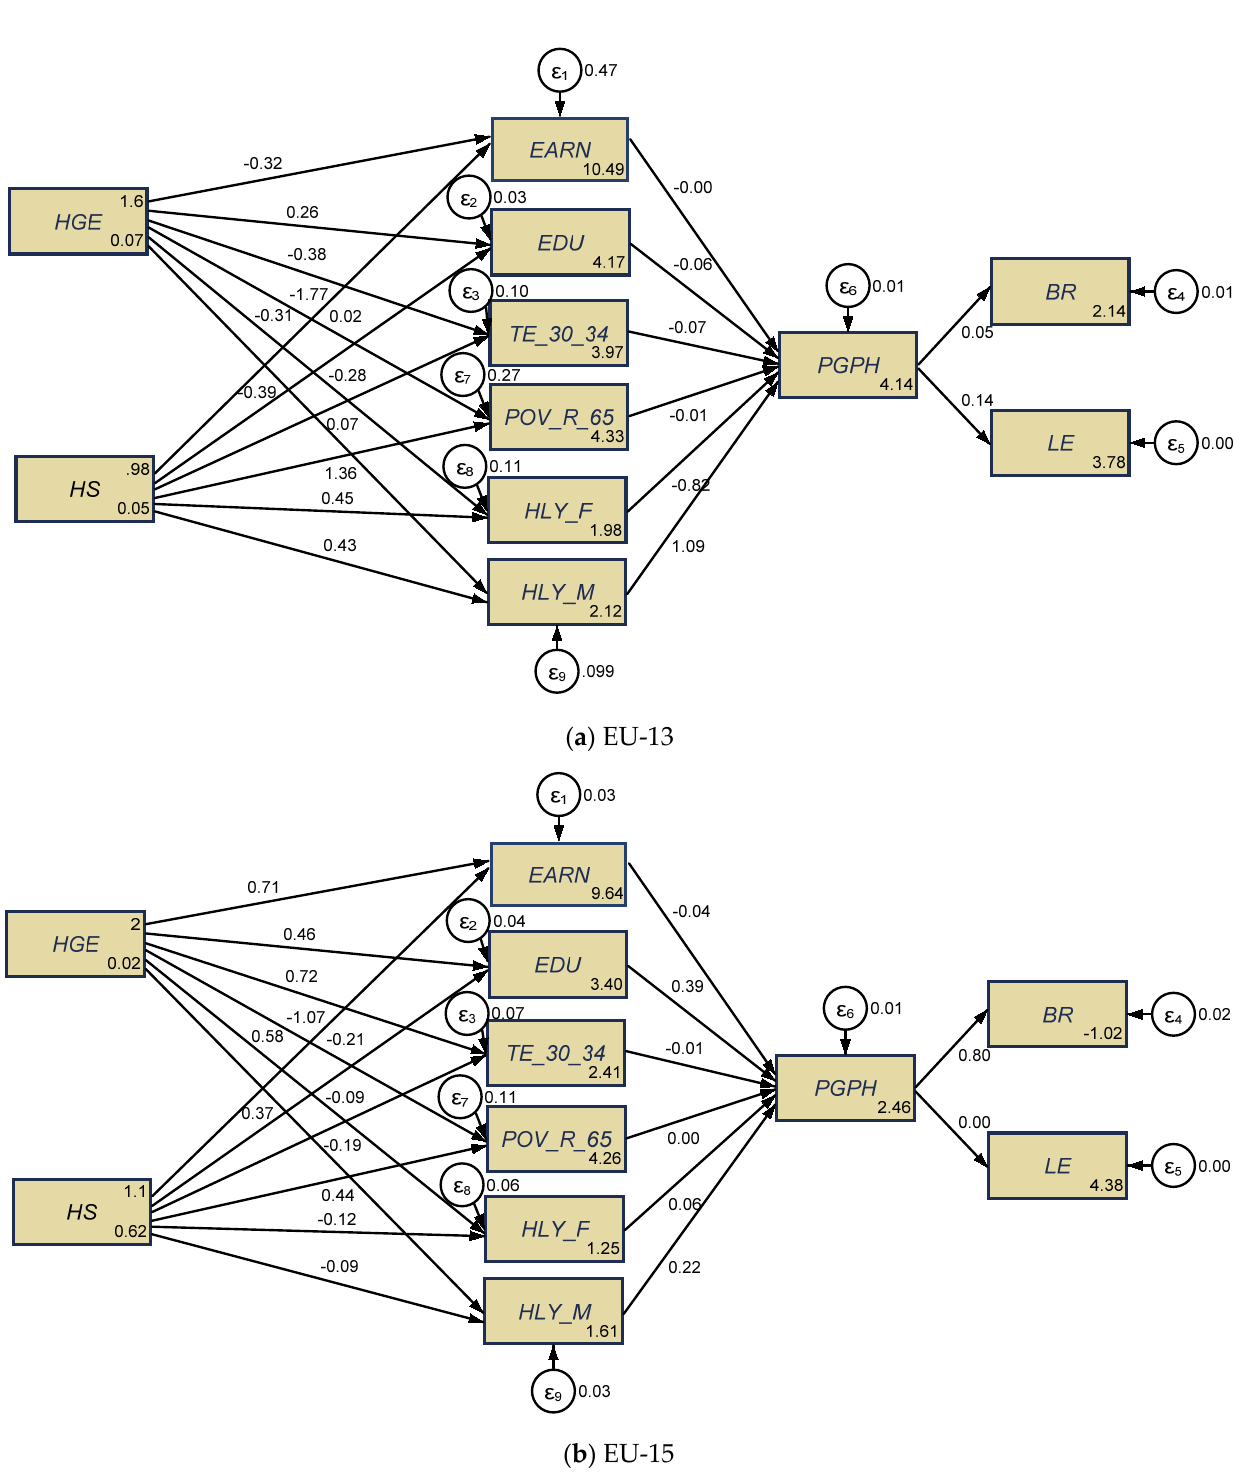
Figure 5. SEM results for the health–aging conjunction, the EU-13 ( a ), and the EU-15 ( b ), for the 1995–2017 lapse of time. Source: authors’ process in Stata 16 (StataCorp LLC, Texas, TX, USA).